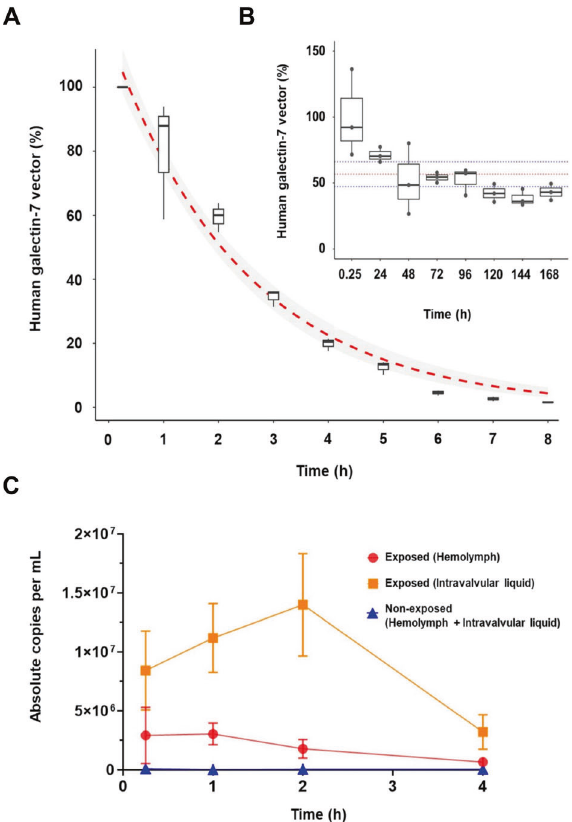
Fig. 1 Experimental accumulation of nonself in mussels. Relative concentration of plasmidic DNA in seawater in presence ( A ) or absence ( B ) of mussels as measured by ddPCR. In A , the results are expressed as percentages and the limits of the box represent the 75th and 25th percentiles. A fi tted logarithmic curve is represented in red with a gray shade area that represents the 95% con fi dence interval. In B , the red line indicates the mean value and blue lines represent the 95% con fi dence interval of the concentrations. C Accumulation of the plasmidic DNA in the hemolymph and intravalvular fl uid of mussels at different time post-addition of plasmidic DNA. The results are shown as absolute number of copies/ mL detected